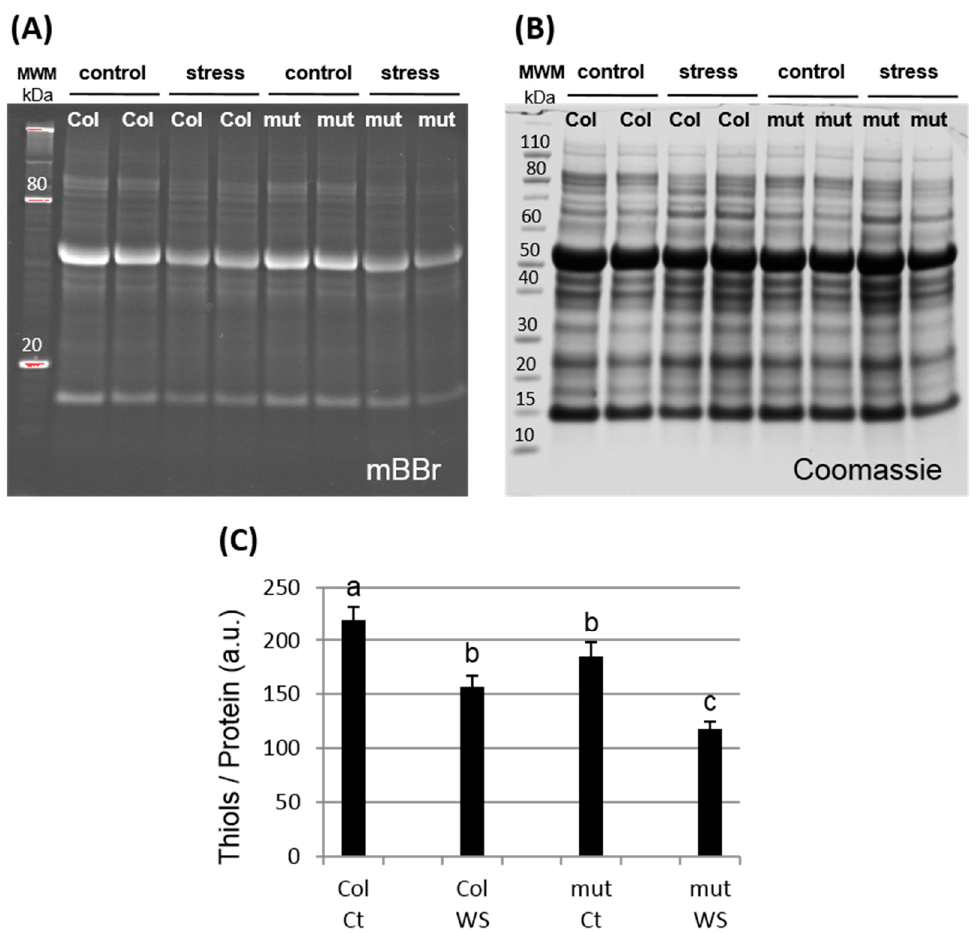
Figure 4. Protein thiols quantification in WT and trxy1y2 mutant leaves after 7 days of drought. ( A ) mBBr fluorescent labelling of protein thiols after SDS-PAGE; ( B ) Coomassie staining of the same gel; ( C ) Thiol content relative to protein content. Ct: control (well watered); WS: water stress (7 days).